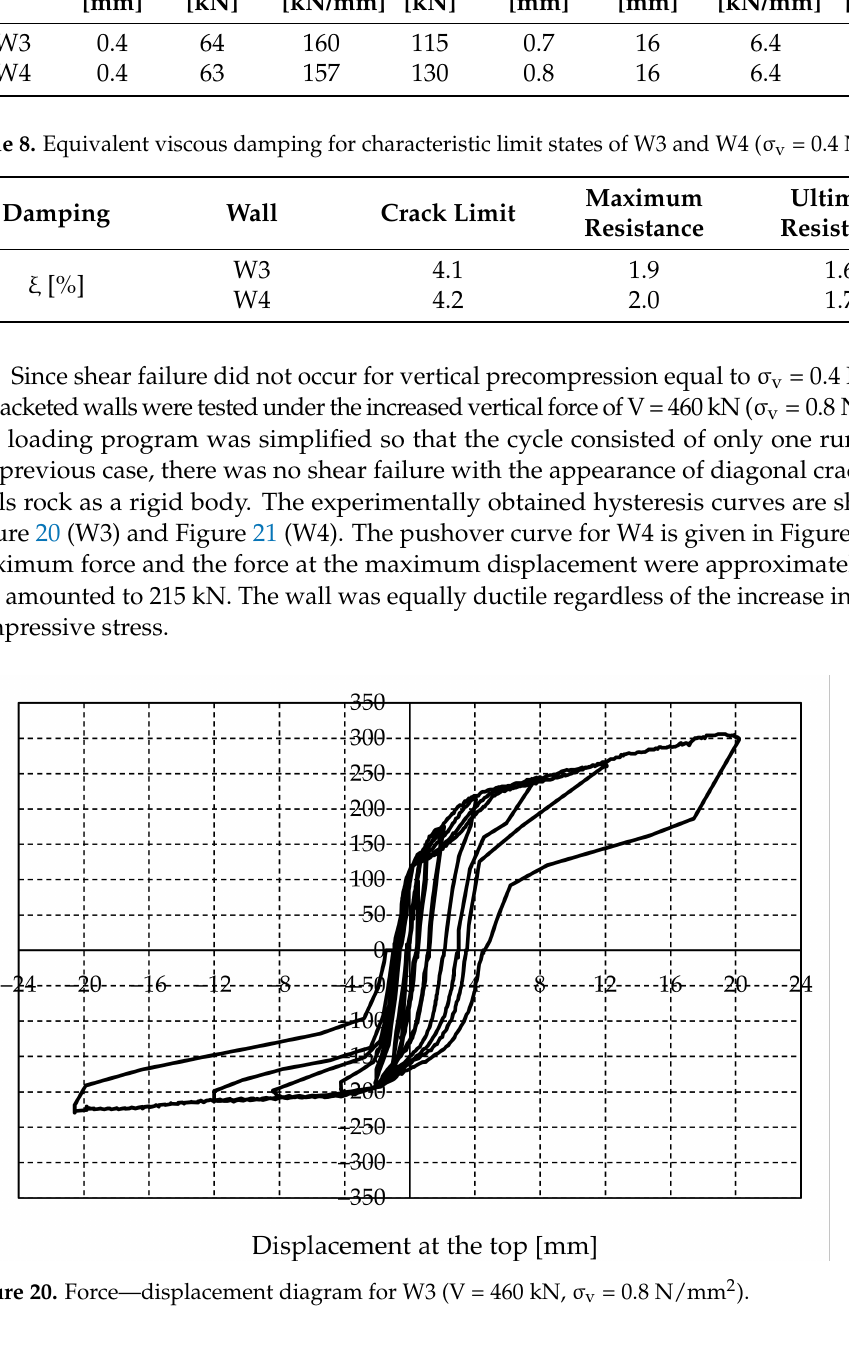
Table 7. Results of bilinear idealization for jacketed walls W3 and W4 ( σ v = 0.4 N/mm 2 ). d cr Wall